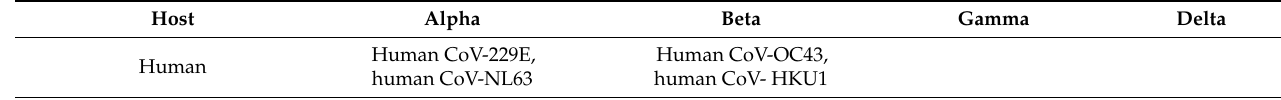
Table 1. Classification of coronaviruses